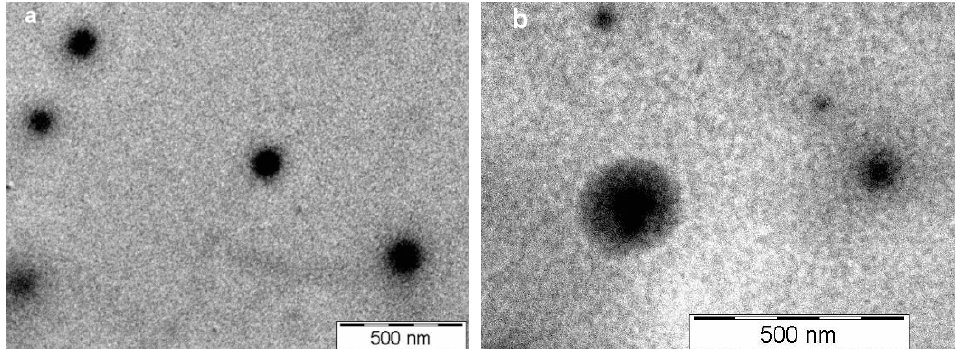
Figure 5. Transmission electron microscopy (TEM) for sample CNM-5 ( a and b ) with two different magnifications.